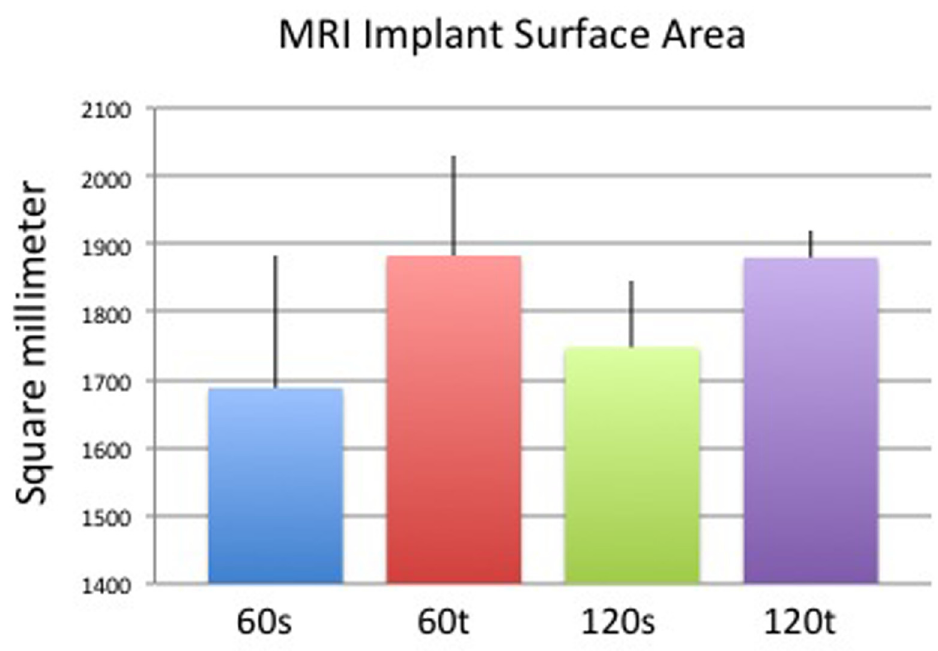
Fig 11. Mean (+/- standard deviation) implant surface area in MRI of each study group. Results were not statistically significant.